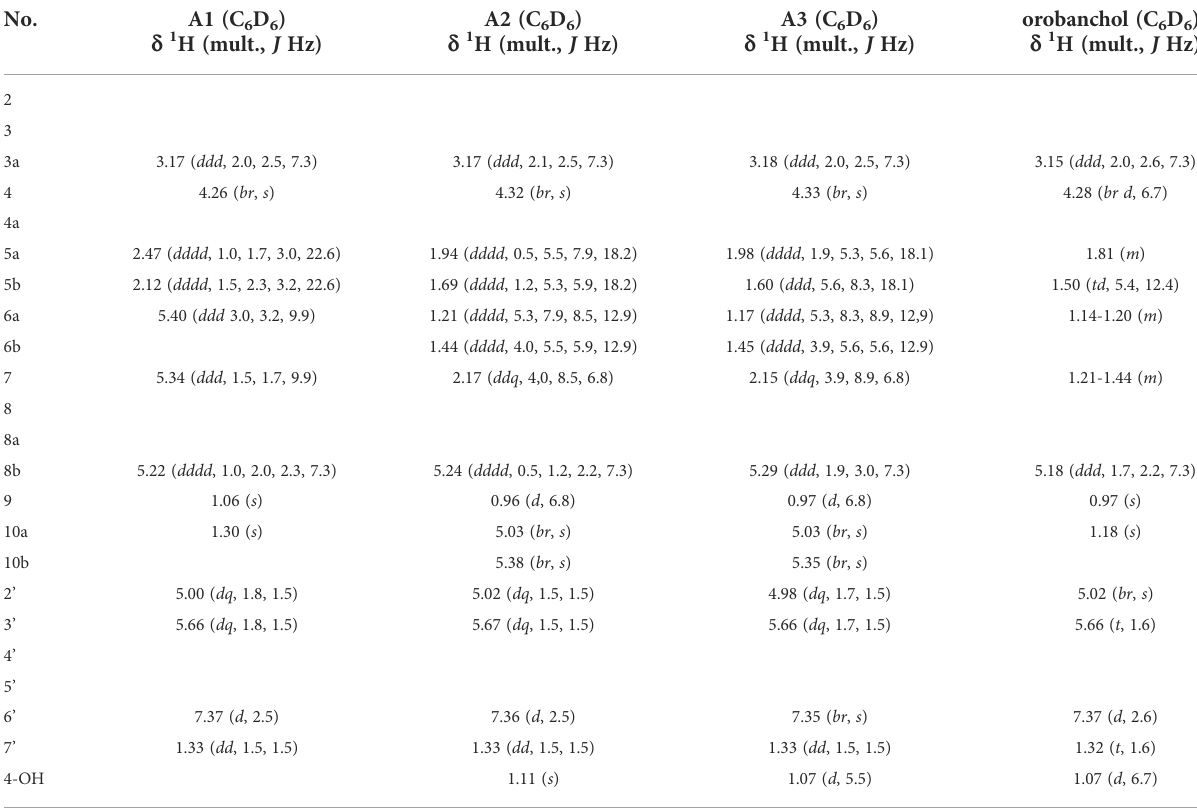
TABLE 1 1 H NMR spectroscopic data of A1, A2 and A3.